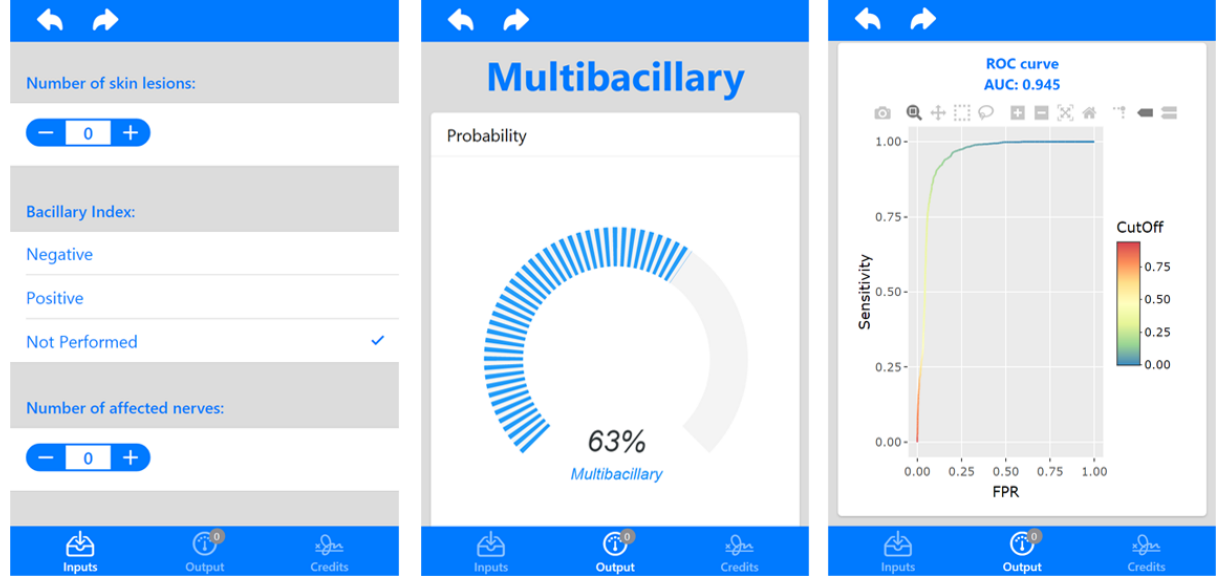
Figure 3. Screenshot representing the R ShinyApp input and output flows. The layout of the app may eventually change to improve user experience. ROC: receiver operating characteristic; AUC: area under the curve; FPR: false positive rate.